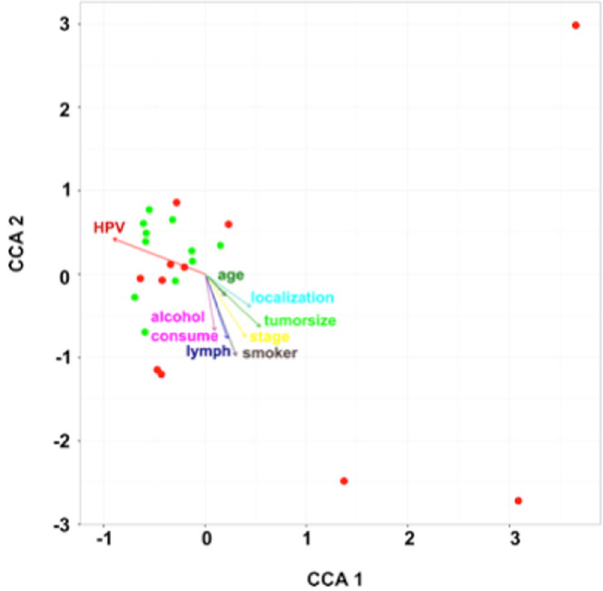
Figure 5. Canonical correspondence analysis (CCA) of the bacterial communities with various